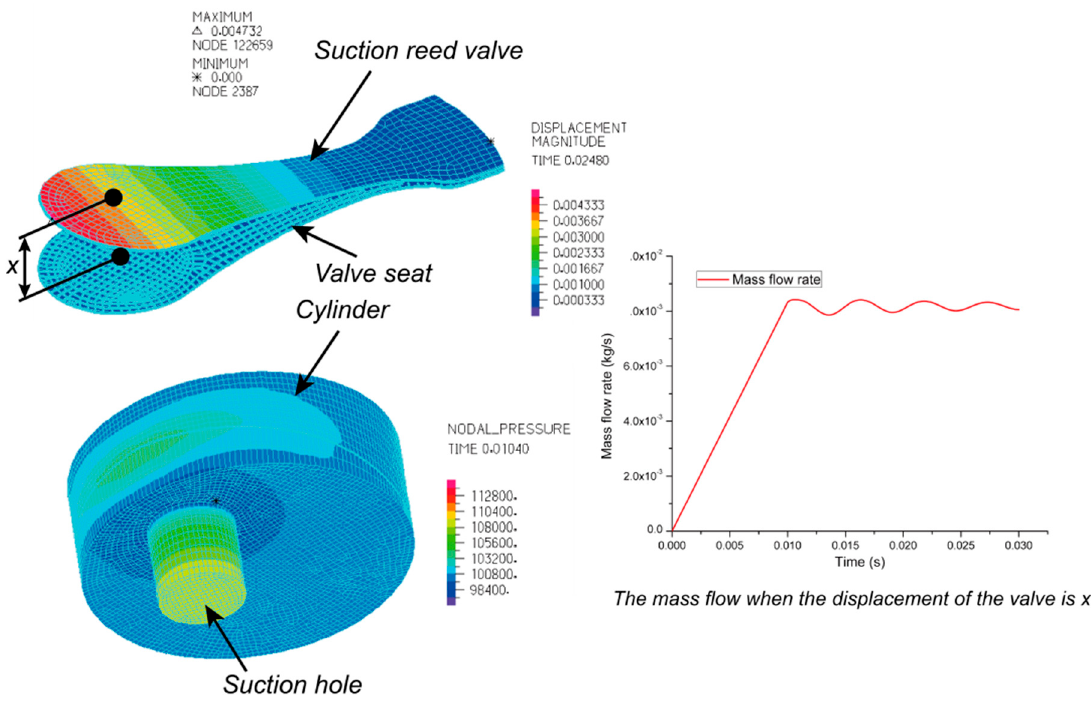
Figure 2. FSI model of the flow through suction reed valve.